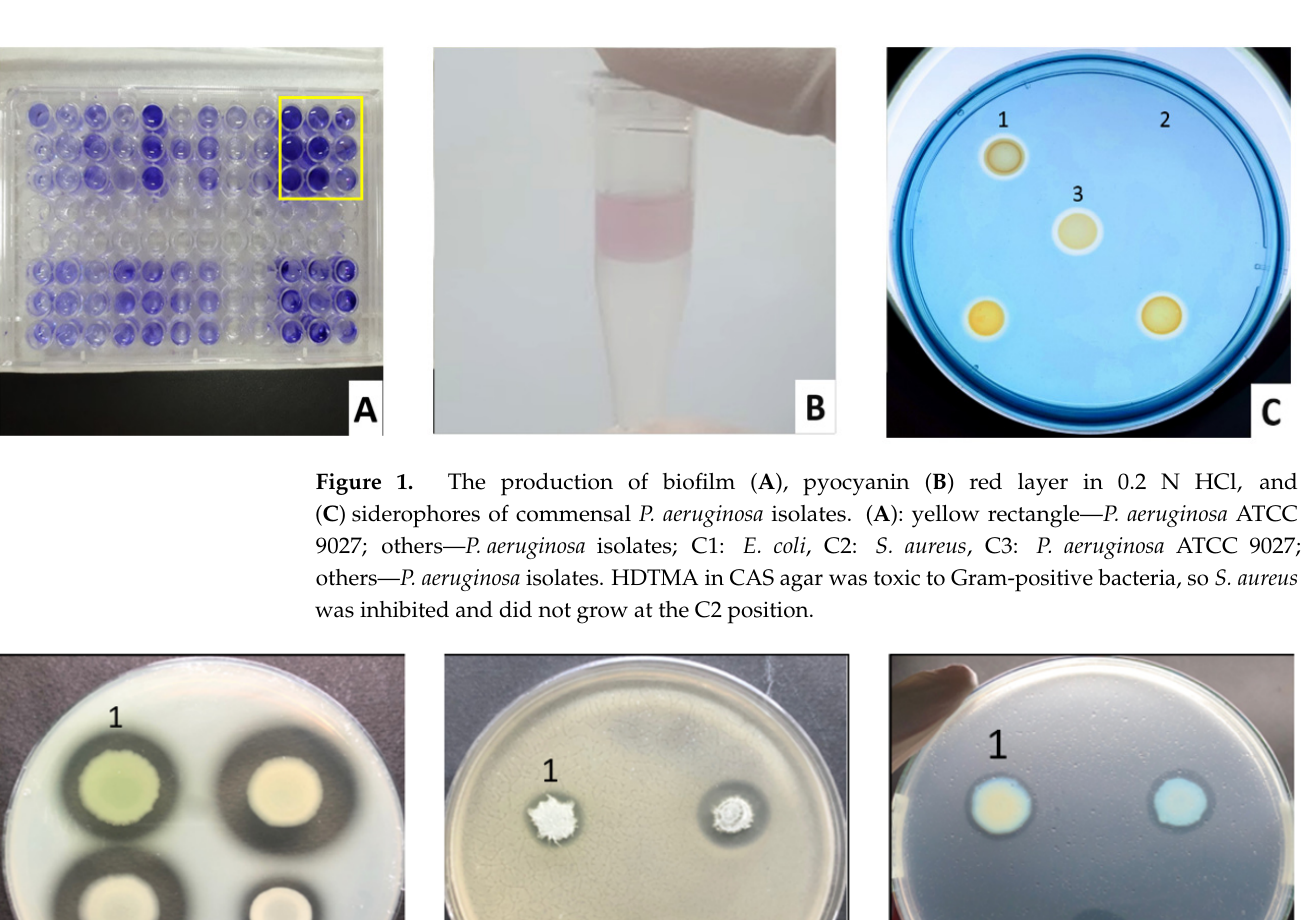
Table S3: oprL —positive Pseudomonas isolates and their colonization sites: Table S4: 16 commensal P. aeruginosa isolates were used in virulence tests; Table S5: Biofilm formation, pyocyanin, and siderophores in commensal P. aeruginosa isolates after inoculation at 37 ◦ C for 24 h. The values were expressed as mean ± standard deviation; Table S6: Lipase, protease, and gelatinase values